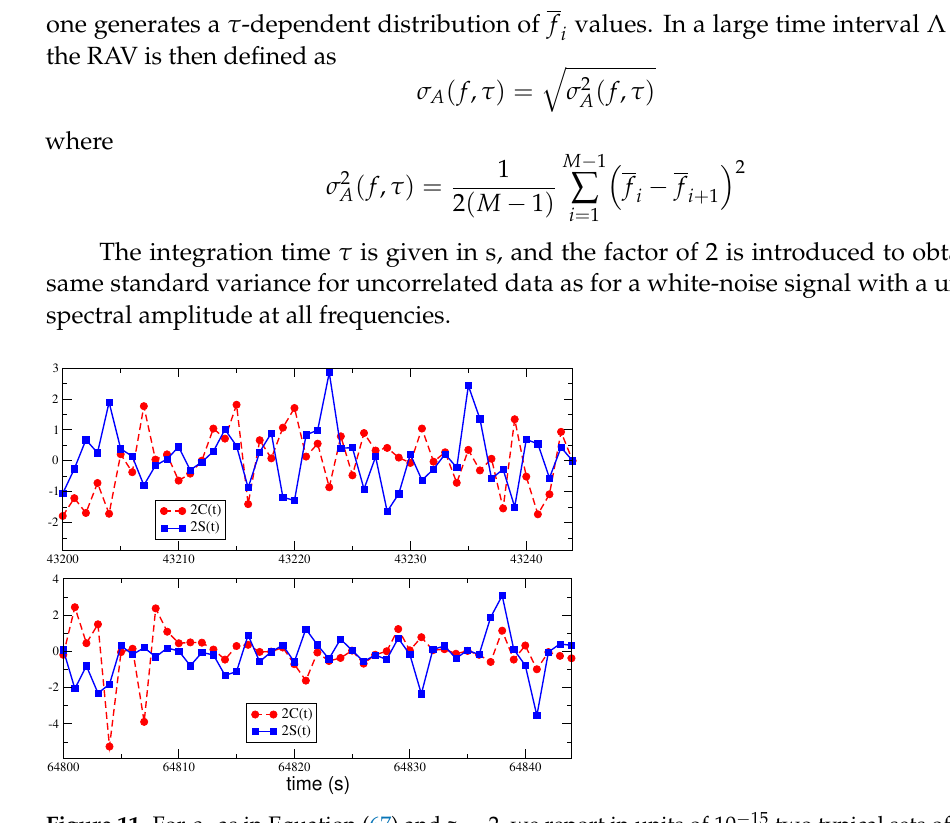
Figure 11. For (cid:101) v as in Equation (67) and z = 2, we report in units of 10 − 15 two typical sets of 45 s for the two functions 2 C ( t ) and 2 S ( t ) of Equation (69). The two sets belong to the same random sequence and refer to two sidereal times that differ by 6 h. The boundaries of the stochastic velocity components in Equations (36) and (37) are controlled by ( V , α , γ ) CMB through Equations (30) and (40). For a laser frequency of 2.8 · 10 14 Hz [51], the range ± 3.5 · 10 − 15 corresponds to a typical frequency shift ∆ ν in the range of ± 1 Hz, as in our Figure